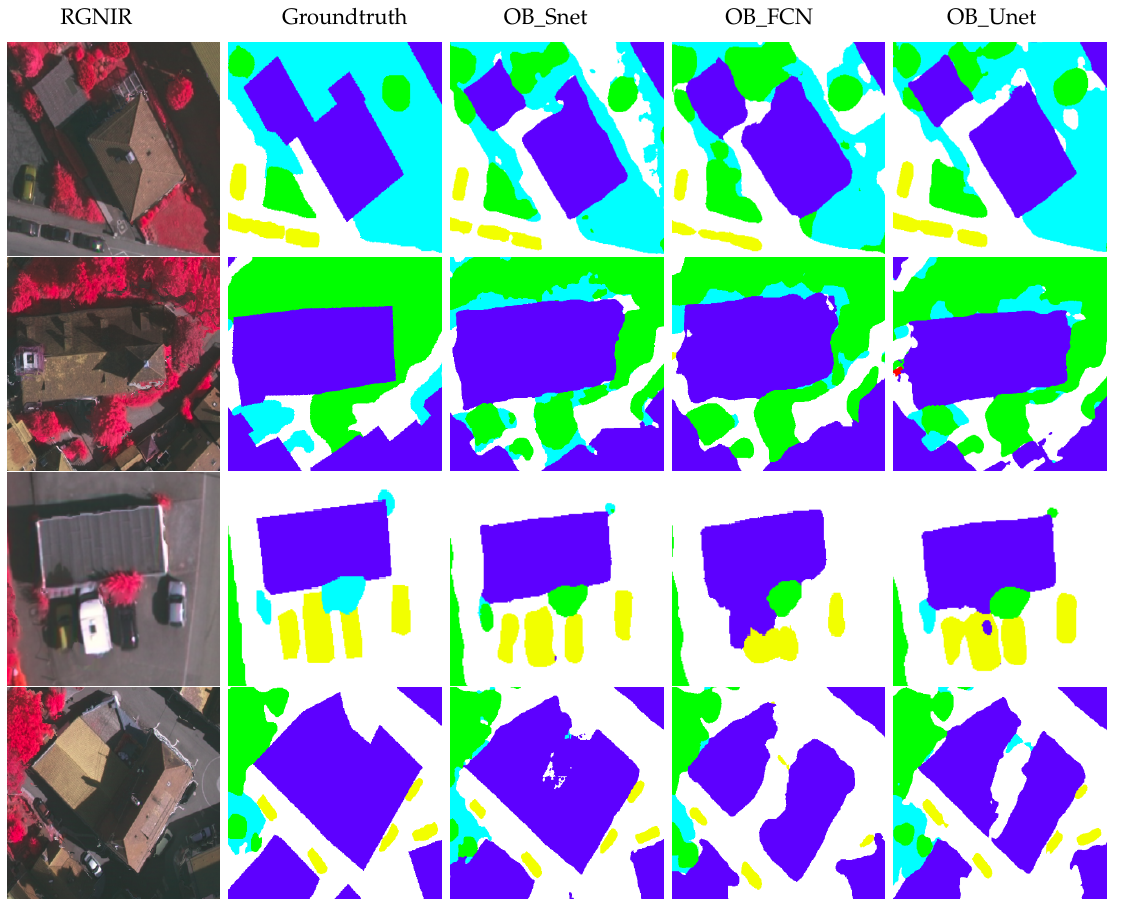
Figure 10. Experimental results from the developed OB_Snet, OB_FCN and OB_Unet networks on indicative regions from the Vaihingen dataset. Along with a false color composite (R-G-NIR), the corresponding ground truth is presented as well (White, Impervious_Surfaces ; Blue, Buildings ; Light Blue, Low_Vegetation ; Green, Trees ; Yellow, Cars ; Red, Clutter